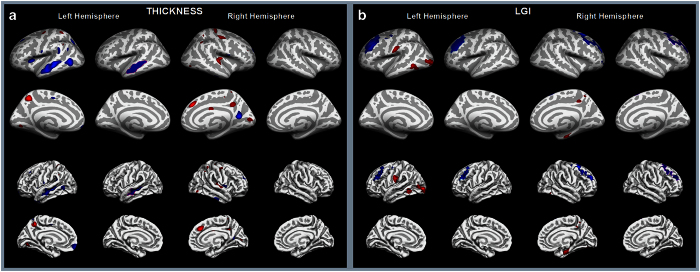
Effect of the translocation on cortical thickness and local gyrification index. (a) Cortical thickness and (b) local gyrification difference between translocation carriers and non-carriers rendered on the inflated and non-inflated cortical surface of the left and right brain templates. Columns 1, 3, 5, and 7 show the significance map of the difference; columns 2, 4, 6, and 8 show the regions that survive the cluster-wise multiple comparisons correction (P<0.05). The blue color indicates that the cortex is thinner and less gyrified for the translocation carriers compared with non-carriers, whereas the red color indicates the opposite effect. All these analyses are controlled for age and sex. Note however that only left superior temporal sulcus cortical thickness and right superior frontal sulcus gyrification index are robust to controlling for intra-familial relatedness (see text). LGI, local gyrification index.